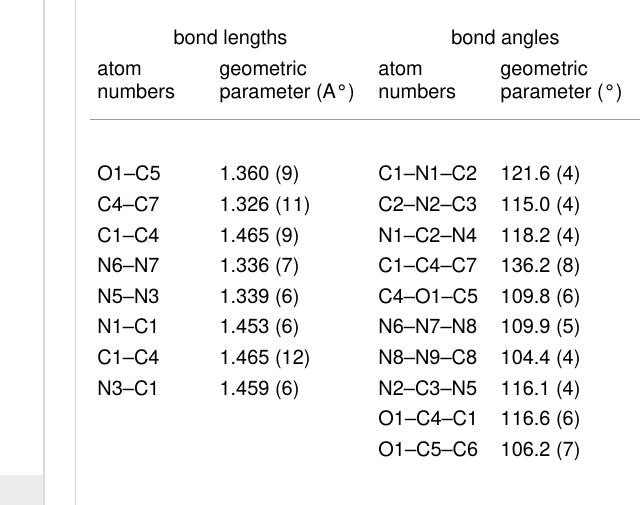
Table 2: Selected bond lengths and bond angles for compound 4i